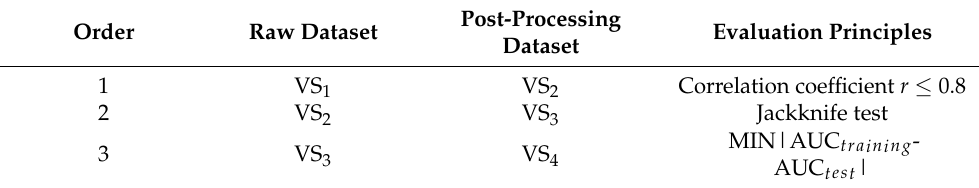
Table 3. The process of environmental variables screening. VS means a dataset, subscripts 1–4